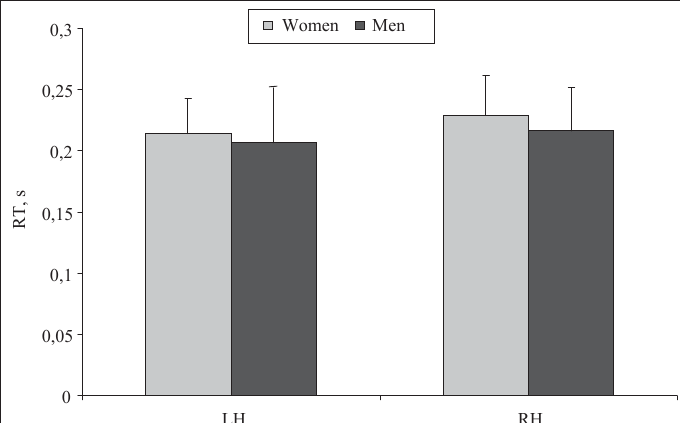
Figure 1. The mean value of simple reaction time (RTs) of males and females performing task with 50 repetitions